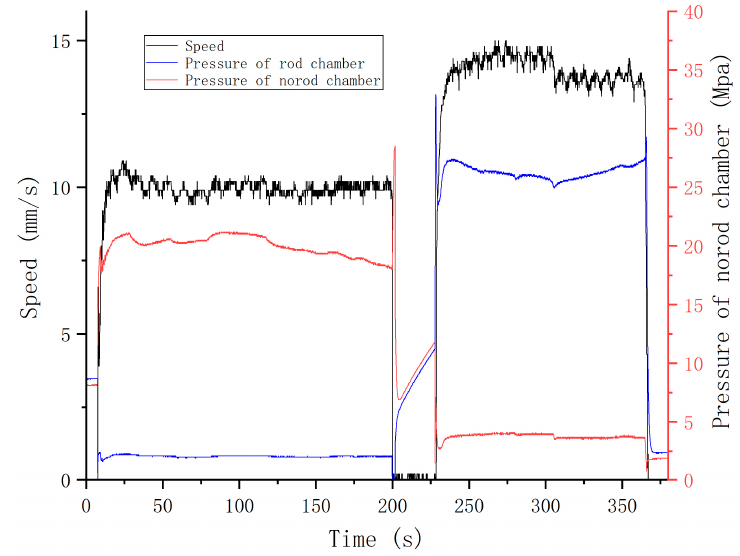
Figure 19. Movement schematic of boom section 2.